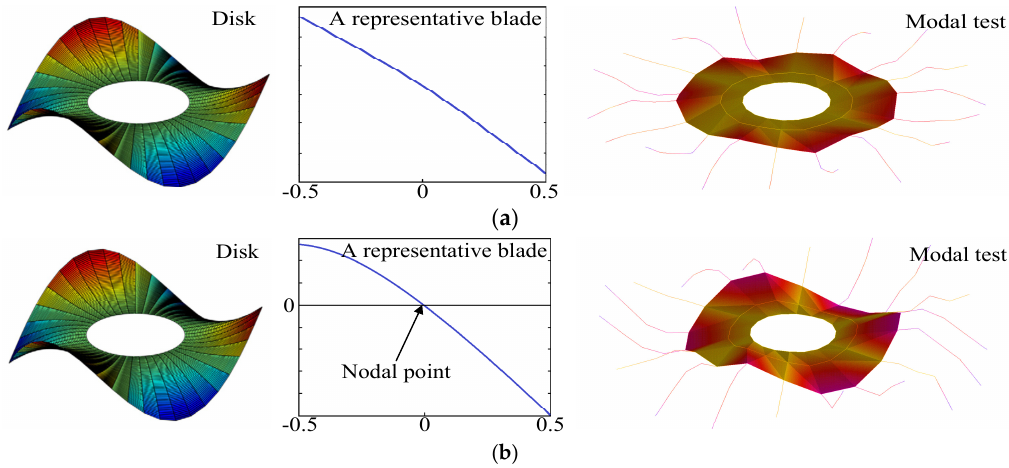
Figure 6. Mode shapes obtained by the Rayleigh-Ritz method and experimental test. ( a ) The first-order mode shapes when n = 3; and ( b ) The second-order mode shapes when n = 3.